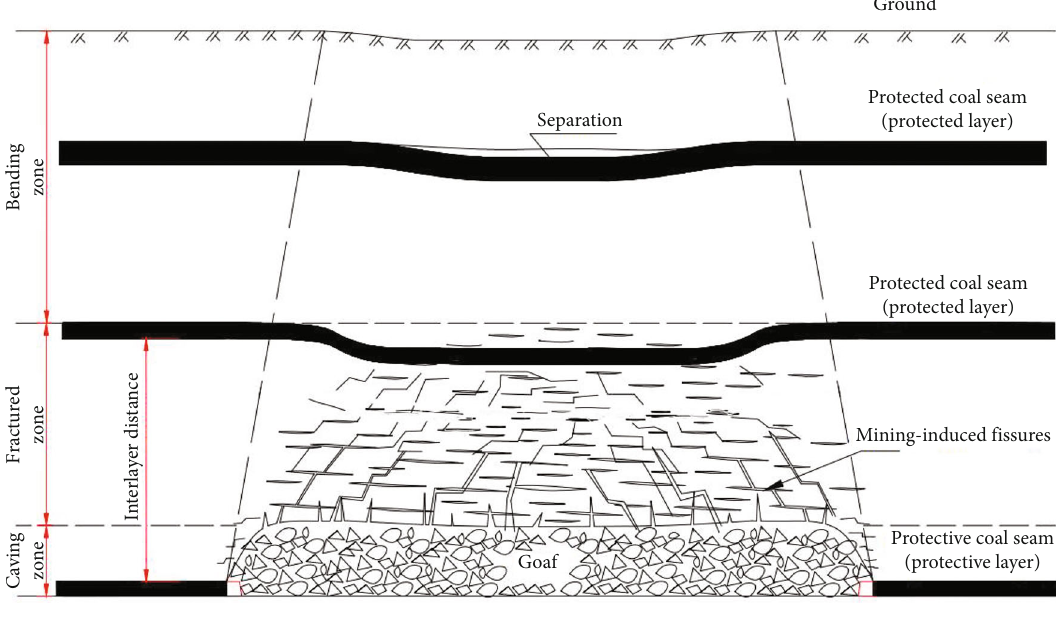
Figure 2: Illustration diagram for lower protective layer mining.